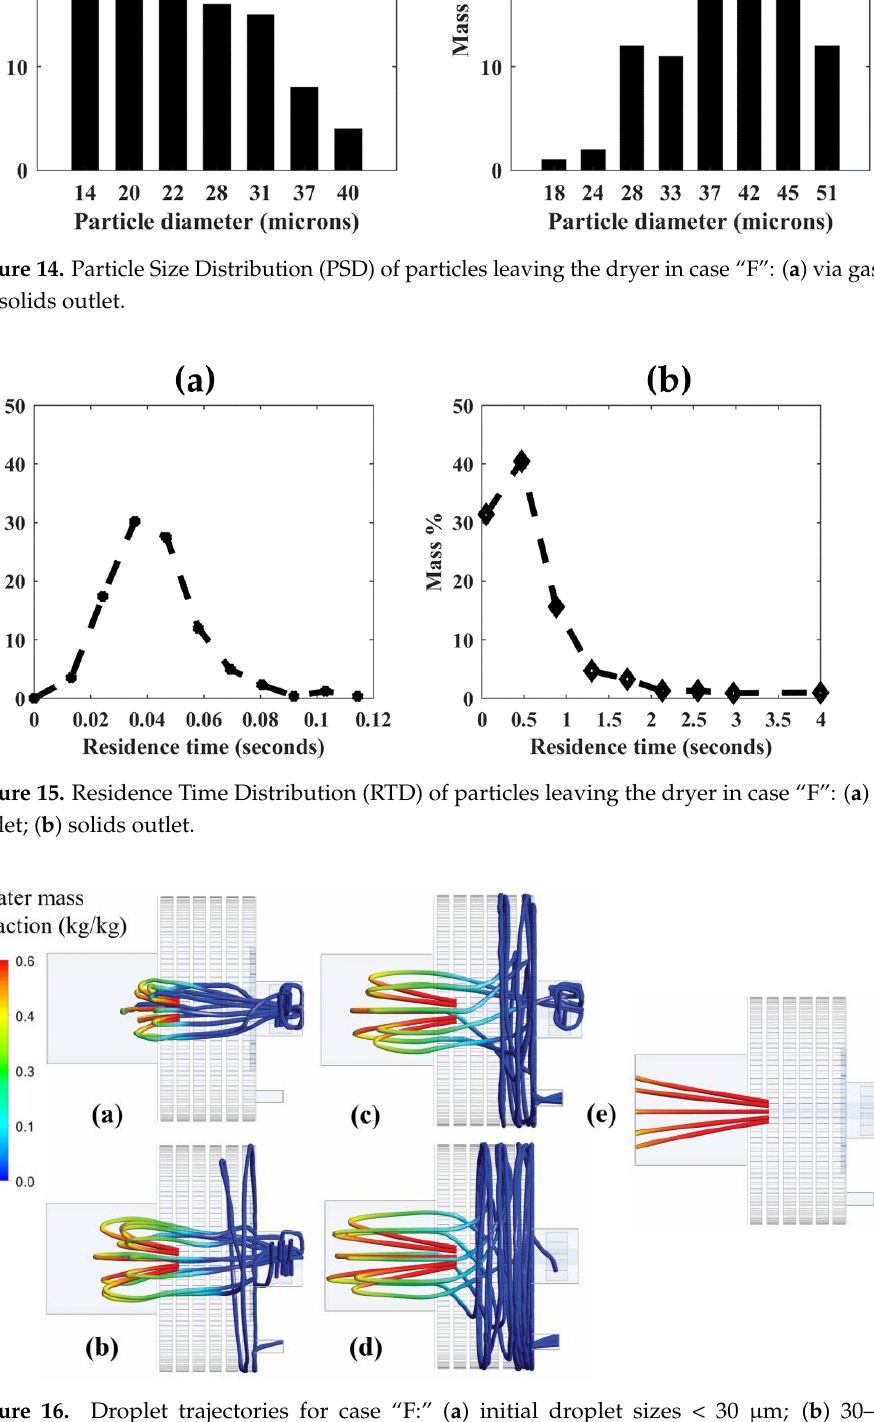
Figure 16. Droplet trajectories for case “F:” ( a ) initial droplet sizes < 30 µm; ( b ) 30 – 45 µm; ( c ) 45 – 60 ( c ) 45–60 µ m; ( d ) 60–75 µ m; and ( e ) >75 µ µm; ( d ) 60 – 75 µm; and ( e ) >75 µm.